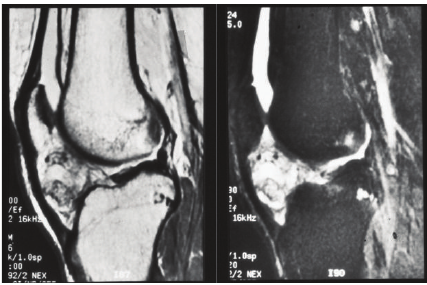
Figure 8: Preoperative MR images, sagittal plane T1- and T2- weighted images, of the knee joint.